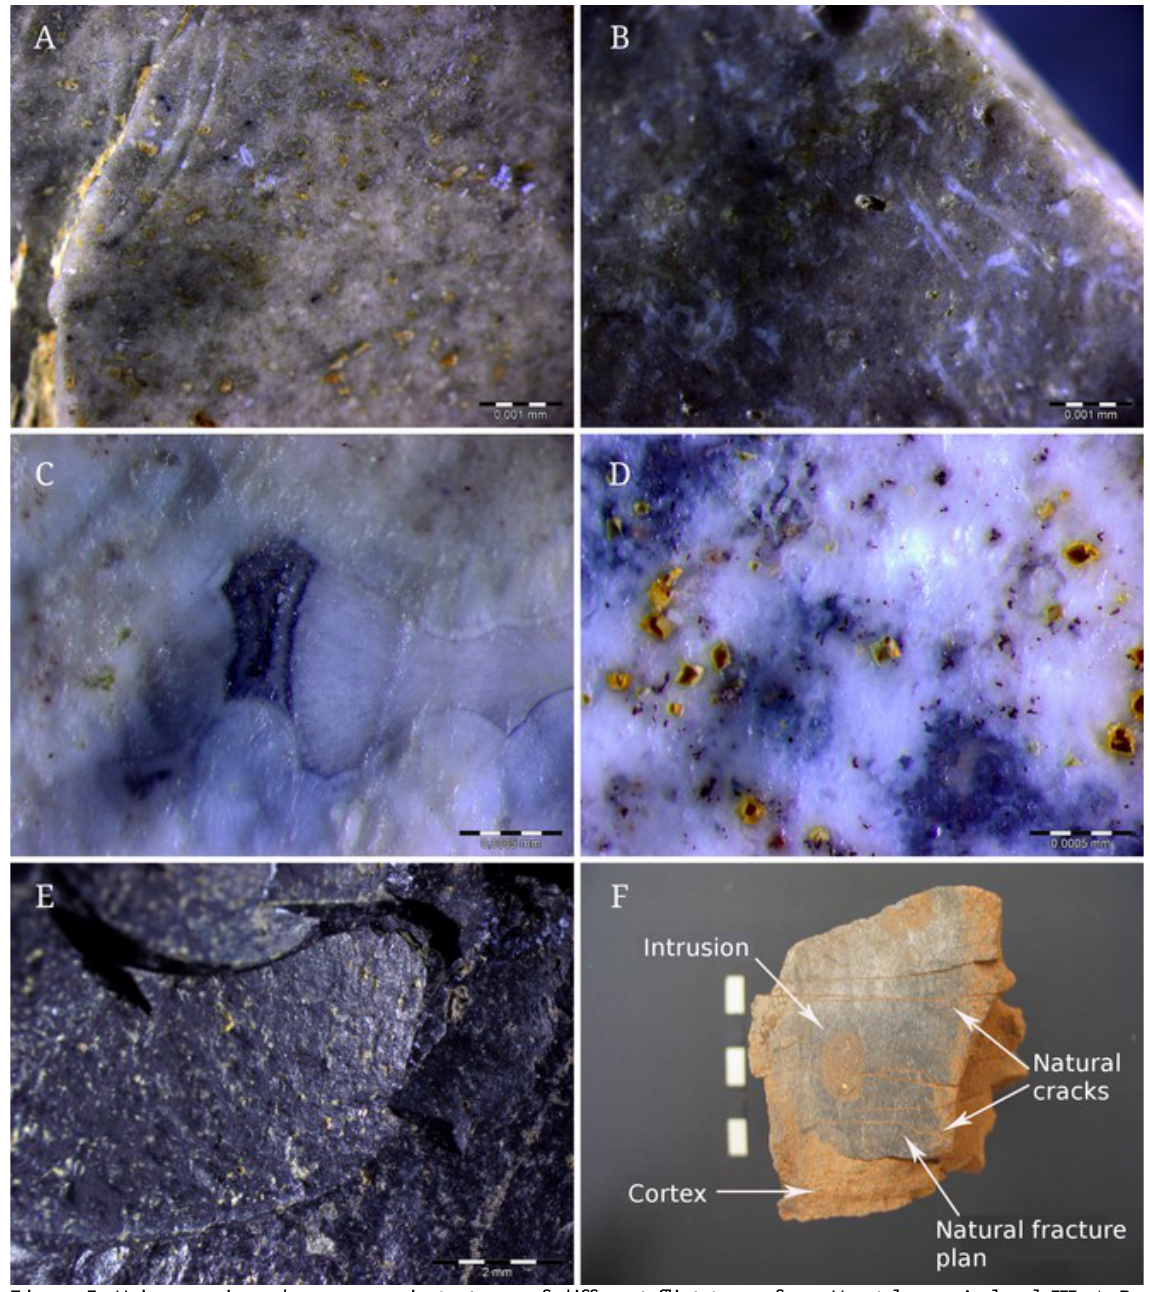
Figure 5. Microscopic and macroscopic textures of different flint types from Ventalaperra’s level III: A-B: Flysch flint; C-D: Translucent flint; E-F: Urgonian